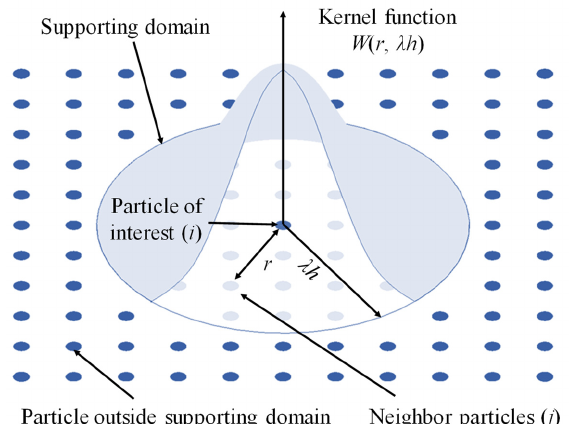
Figure 1. A schematic presentation of the SPH kernel function W (reproduced with minor changes from Atif et al. [86], with permission from Copyright Clearance Center, Inc. (CCC) on behalf of Springer-Verlag, Dordrecht, Netherlands).